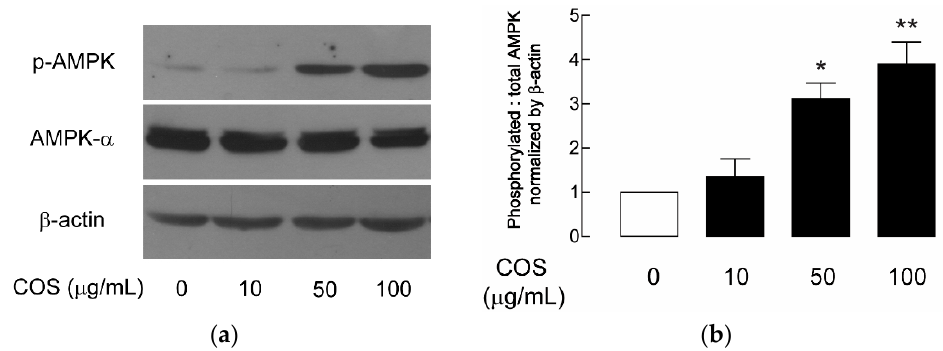
Figure 3. Effect of COS on AMPK activation in MDCK cells. ( a ) Representative immunoblots of five separate experiments for the expression of p-AMPK, AMPK- α , and β -actin were performed. MDCK cells were incubated with COS at 10, 50, or 100 µg/mL or vehicle for 24 h before collecting samples for immunoblotting analysis. ( b ) Densitometry analysis of p-AMPK corrected by total AMPK and β -actin is depicted. Data are expressed as mean ± S.E.M. ( n = 5). * p < 0.05; ** p < 0.01 compared with control.